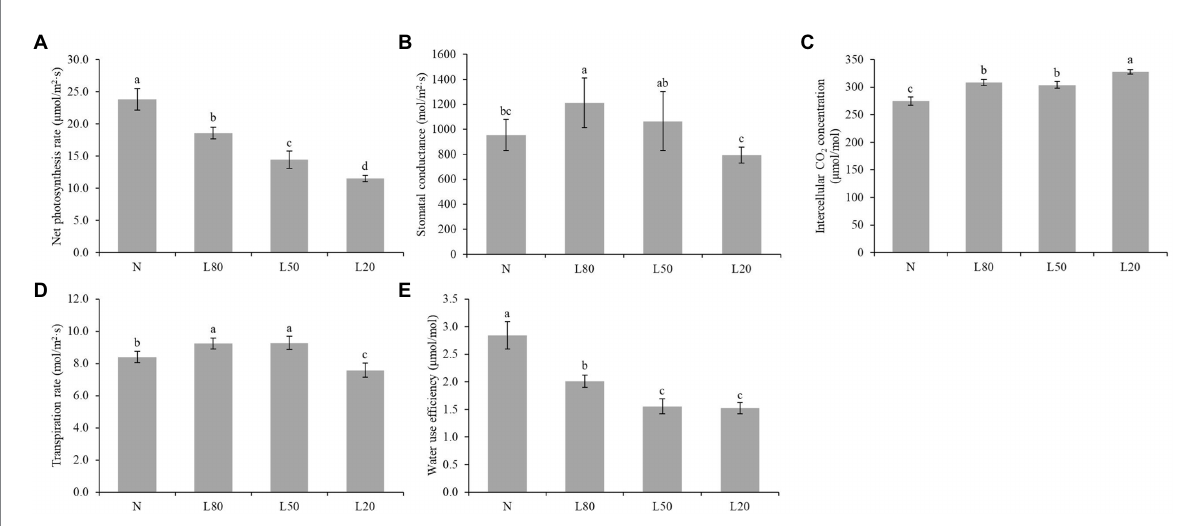
FIGURE 3 Changes in photosynthetic indicators of J. mandshurica under shade. (A) Net photosynthetic rate (Pn). (B) Stomatal conductance (Gs). (C) Intercellular CO 2 concentration (CI). (D) Transpiration rate (Tr). (E) Water use efficiency (WUE). N: natural sunlight. L80: 80% sunlight to go through. L50: 50% sunlight to go through. L20: 20% sunlight to go through. Error bars represent the standard error. Different letters indicate significant differences between different treatments.